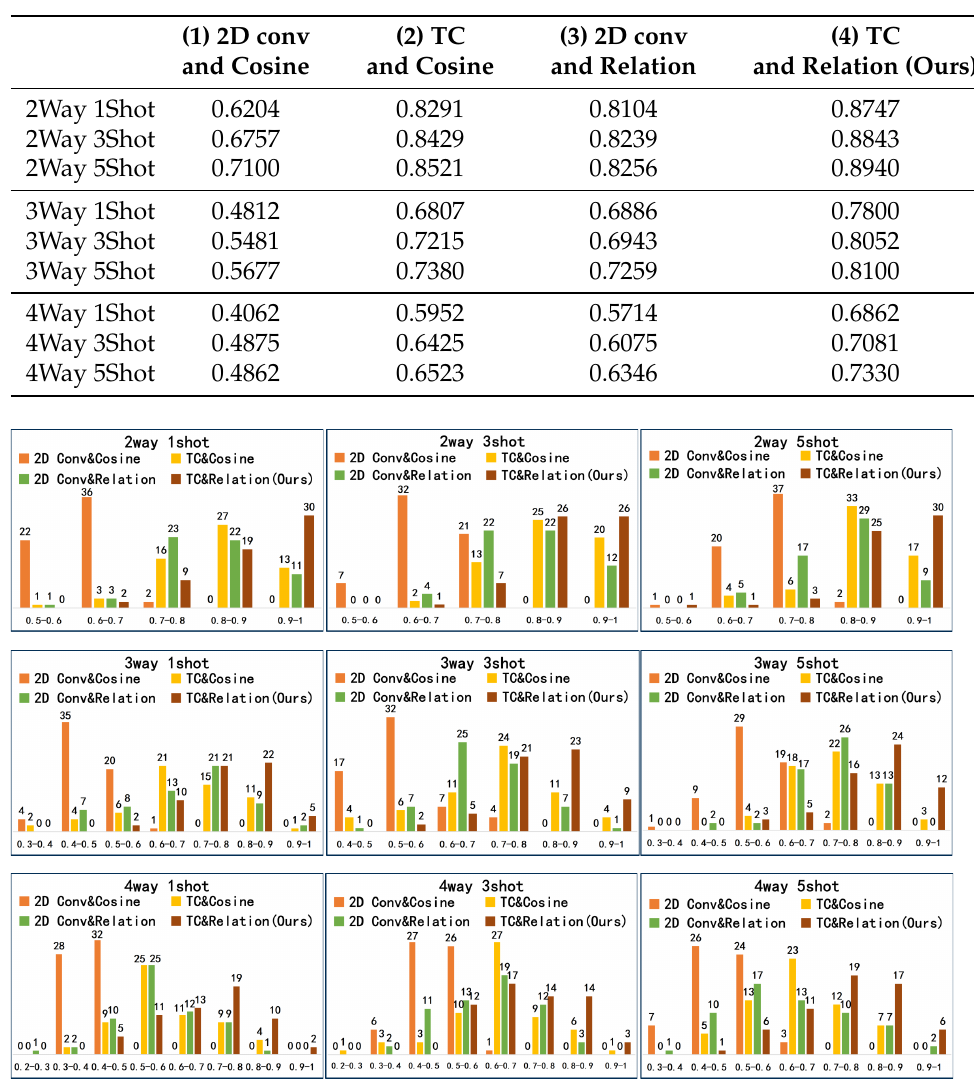
Figure 4. Statistical histograms of the results of 60 trials for 4 networks which are constructed using different embedding and metric modules. In the figure, 2D-Conv represents the 2D convolutional module and TC represents the TriangleConv module. Each subplot shows the distribution of the results of 60 trials for each model in different value intervals. The horizontal coordinates in the subplot are value